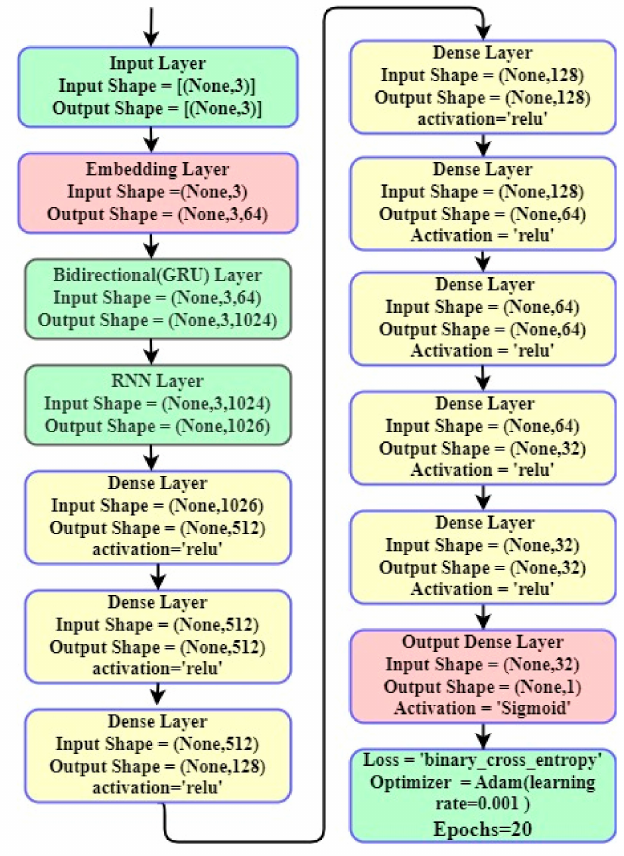
Figure 8. The architectural analysis of our proposed BiGR